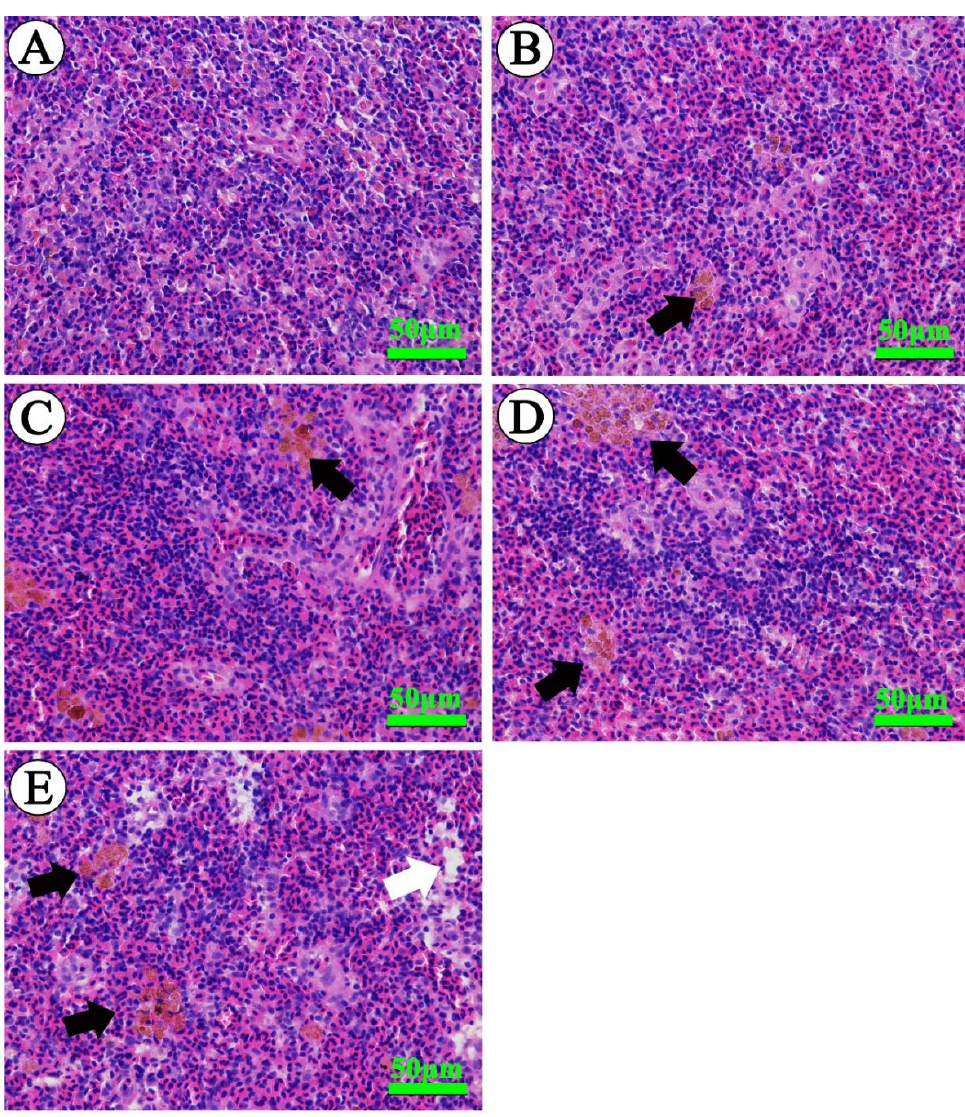
Figure 4. Light microscope photographs of spleens of M. amblycephala (H&E). ( A ) Spleen tissue of control fish showing normal architecture. ( B – D ) Spleen tissues from fish exposed to 5, 10 and 20 mg/L ammonia nitrogen showing an increase in erythrocytes and melano-macrophage centers (black arrows). ( E ) Spleen tissue from fish exposed to 30 mg/L ammonia nitrogen showing increased melano-macrophage centers (black arrows) as well as cytoplasm vacuolization (white arrows). Scale bar = 50 μm.